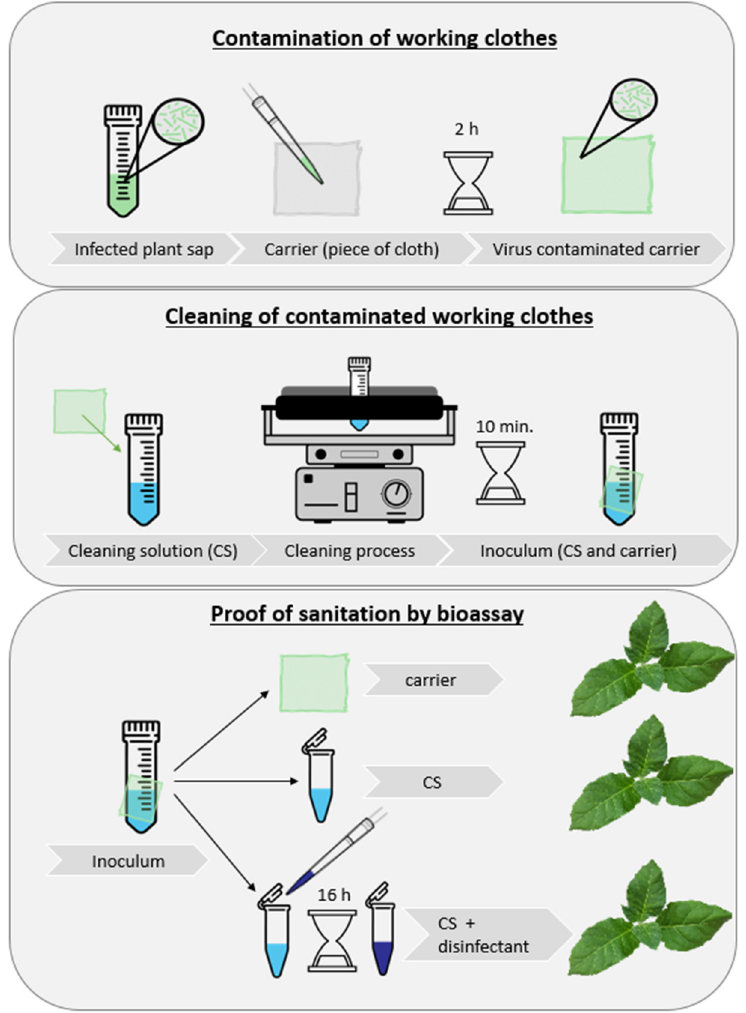
Figure 1. Methodical approach of cleaning Tomato brown rugose fruit virus (ToBRFV)-contaminated clothing and proof of sanitation via bioassay on Nicotiana tabacum cv. Xanthi NN.